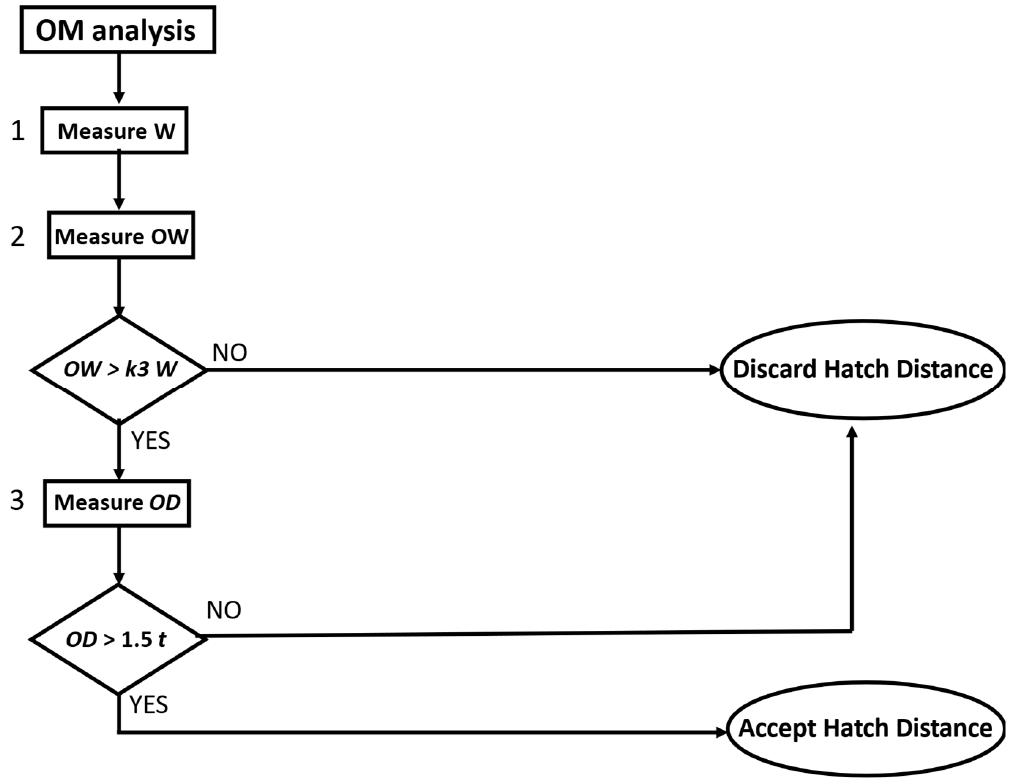
Figure 10. Flowchart of multi tracks analysis starting from Optical Microscope (OM) analysis.